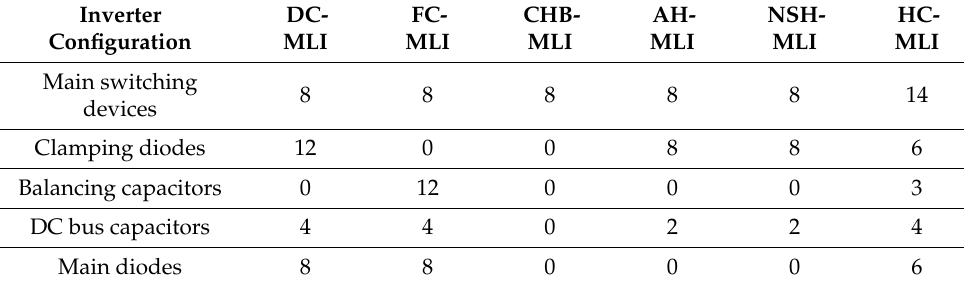
Table 2. Comparison of components required for various topologies.